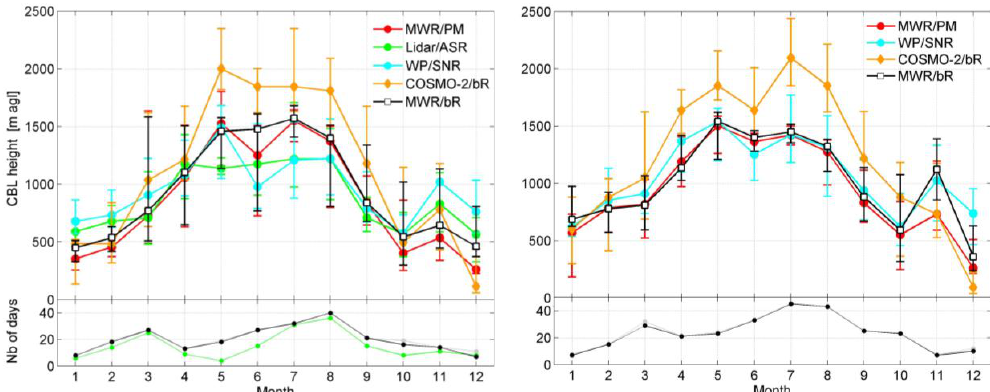
Figure 9. Upper panel: CBL height 2-year climatology at PAY (left) and SHA (right). The symbols are the monthly median of the daily medians of the CBL height taken between 12:00 and 15:00; the error bars are the 25th and 75th percentiles. Lower panel: the number of CBL days used for calculating the monthly medians are given in grey for MWR/PM, WP/SNR and COSMO-2/bR, in black for MWR/bR and in green for lidar/ASR.